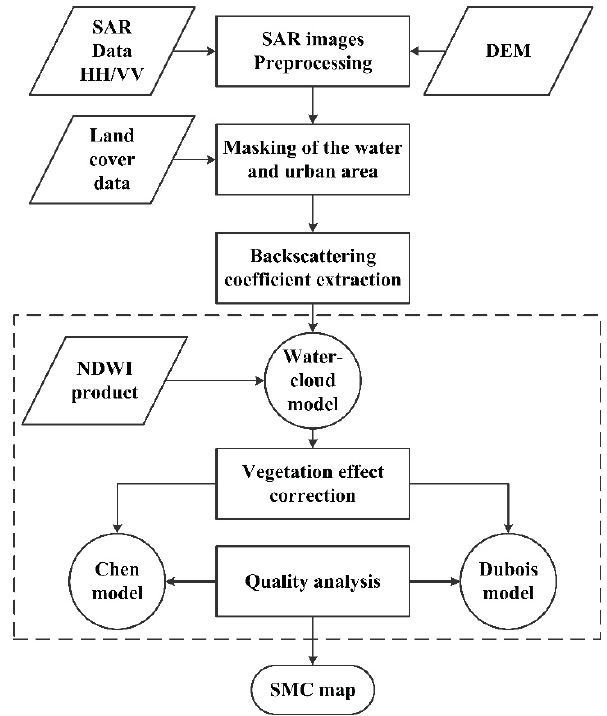
Figure 3. Flowchart of soil moisture